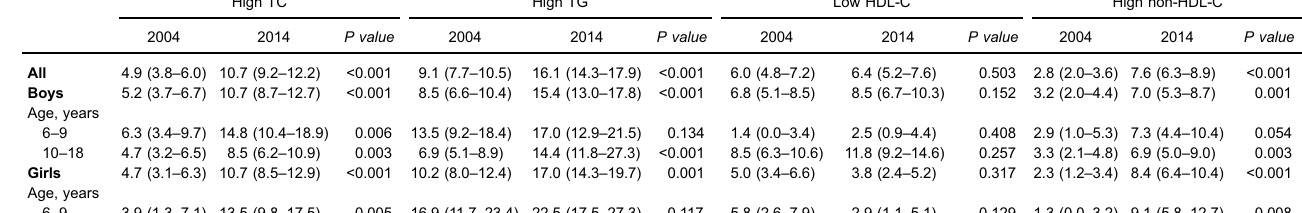
Table 3. Prevalence of abnormal serum lipids over time by sex and age among children and adolescents in Beijing, 2004 – 2014 High TC High TG Low HDL-C High